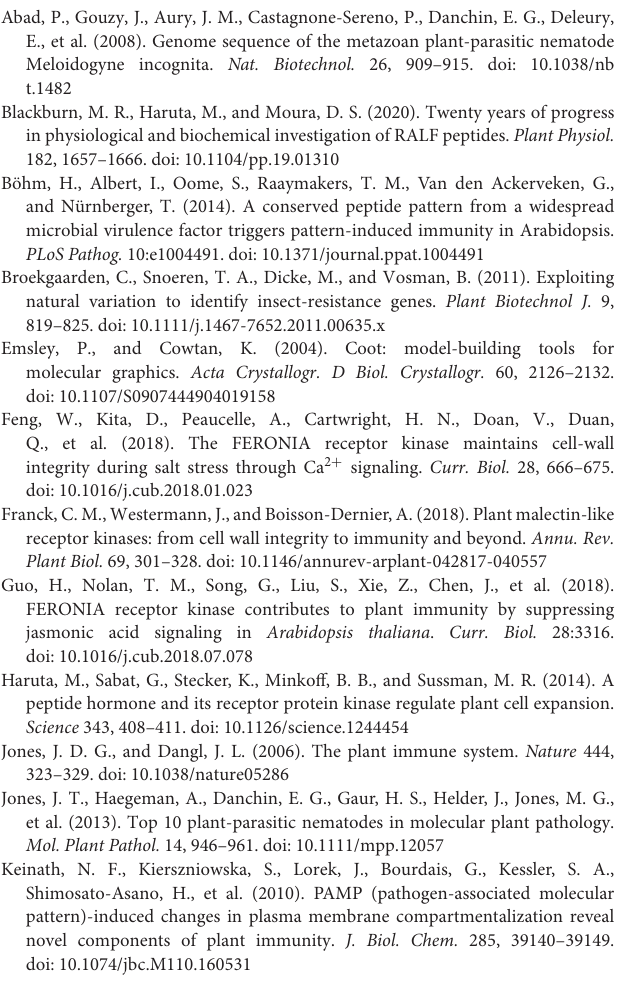
Supplementary Figure S6 | Nematode numbers of Col-0 and fer-4 plant roots treated with exogenous 1 µ M MiRALF1 and AtRALF1 peptides at 3 dpi. Data are presented as the mean ± S.D., n ≥ 10; Student’s t -test ( ∗∗ p < 0.01; n.s., not significant) and RALF-like peptides were heterologously expressed in E. coli . Supplementary Figure S7 | Nematode numbers per gram root of the cultivars with different GmLMM1 haplotypes grouped based on the three nonsynonymous SNPs. (A) SNP1 of 25A/C (p. T9P) showed no significance in nematode numbers. (B) SNP2 of 119C/A (p. T40N) showed no significance in nematode numbers. (C) SNP3 of 1075A/C (p. N359H) showed a significance in nematode numbers. Data are presented as the mean ± S.D., n ≥ 10; Student’s t -tests. Supplementary Figure S8 | 3D structure analysis of GmLMM1. (A) The 3D structure of the AtRALF23-GmLLG2/GmLMM1 ECD complex. AtRALF23, GmLLG2, and GmLMM1 ECD are colored light green, blue, and clay bank, respectively. The black frame indicated the position of N359. (B) The 3D structure of GmLMM1 ECD and GmLMM1 ECDN359H predicted by AlphaFold. The black frame indicated the position of N359. (C) The difference of N359 and H359 in the GmLMM1 ECD 3D structure. Supplementary Table S1 | Primers used in this